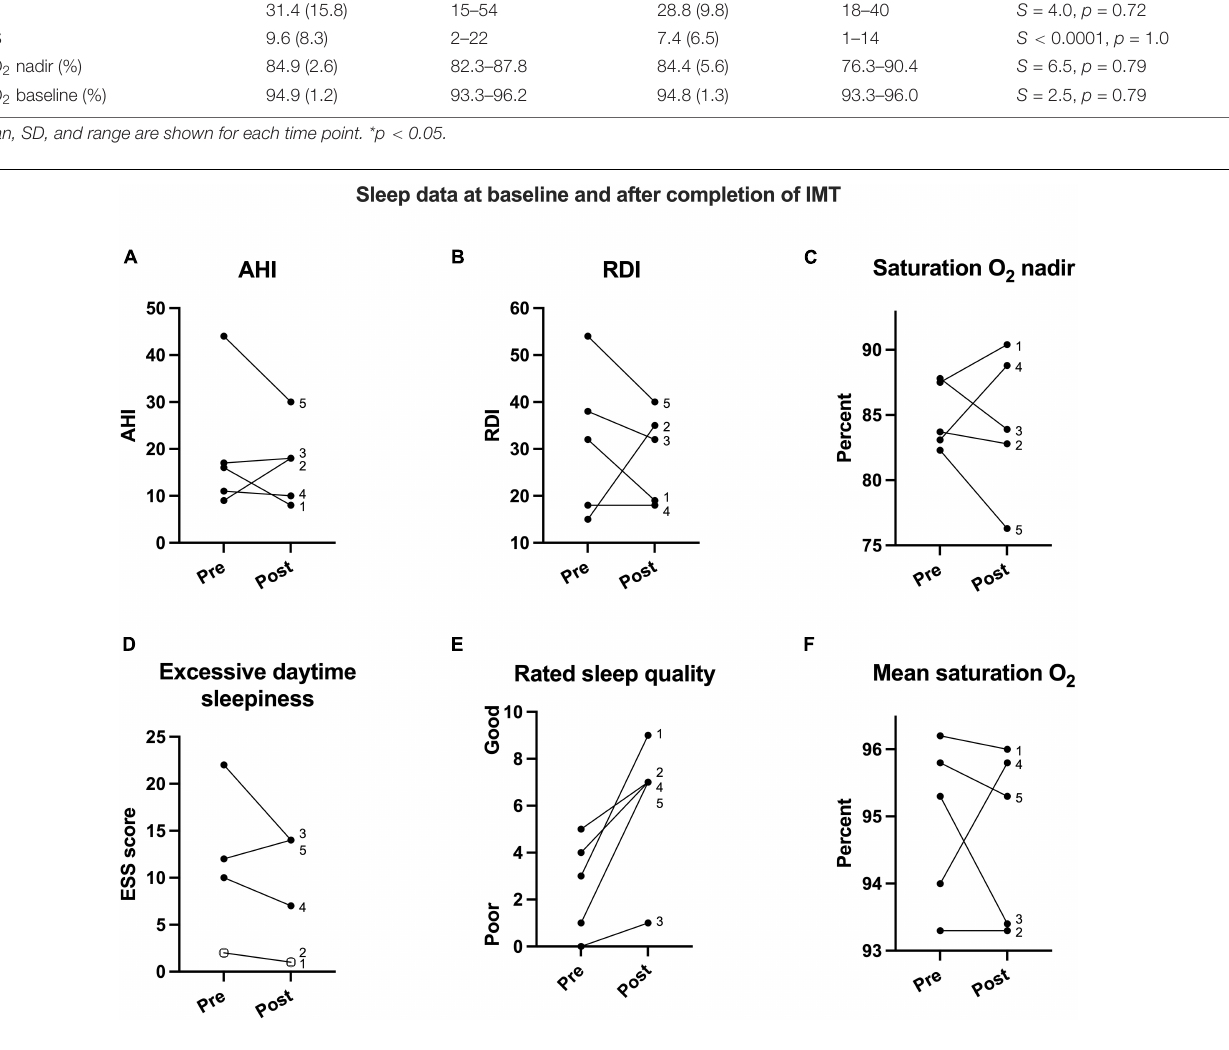
FIGURE 3 | Sleep data for all five participants labeled 1 through 5. While apnea hypopnea index (AHI; A ), respiratory disturbance index (RDI; B ), oxygen saturation at nadir (SaO 2 ; C ), and the all-night oxygen saturation average (SaO 2 ; F ) showed individual variation, subjective rating for daytime sleepiness ( D ; participants 1 and 2 overlap here) decreased and therefore improved, and rated sleep quality (E) improved in all five participants from baseline to post-IMT